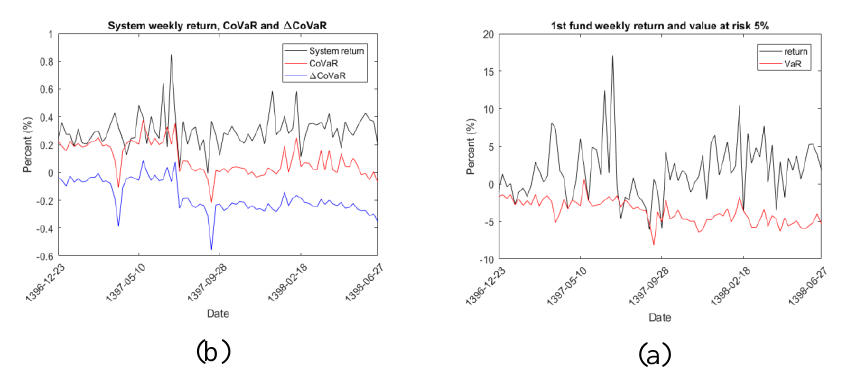
Figure 3. The Graphs of a) Weekly Return and VaR of Bourseiran Mutual Fund, b) Weekly System return, CoVaR, and ΔCoVaR from Early March 2017 to Late September